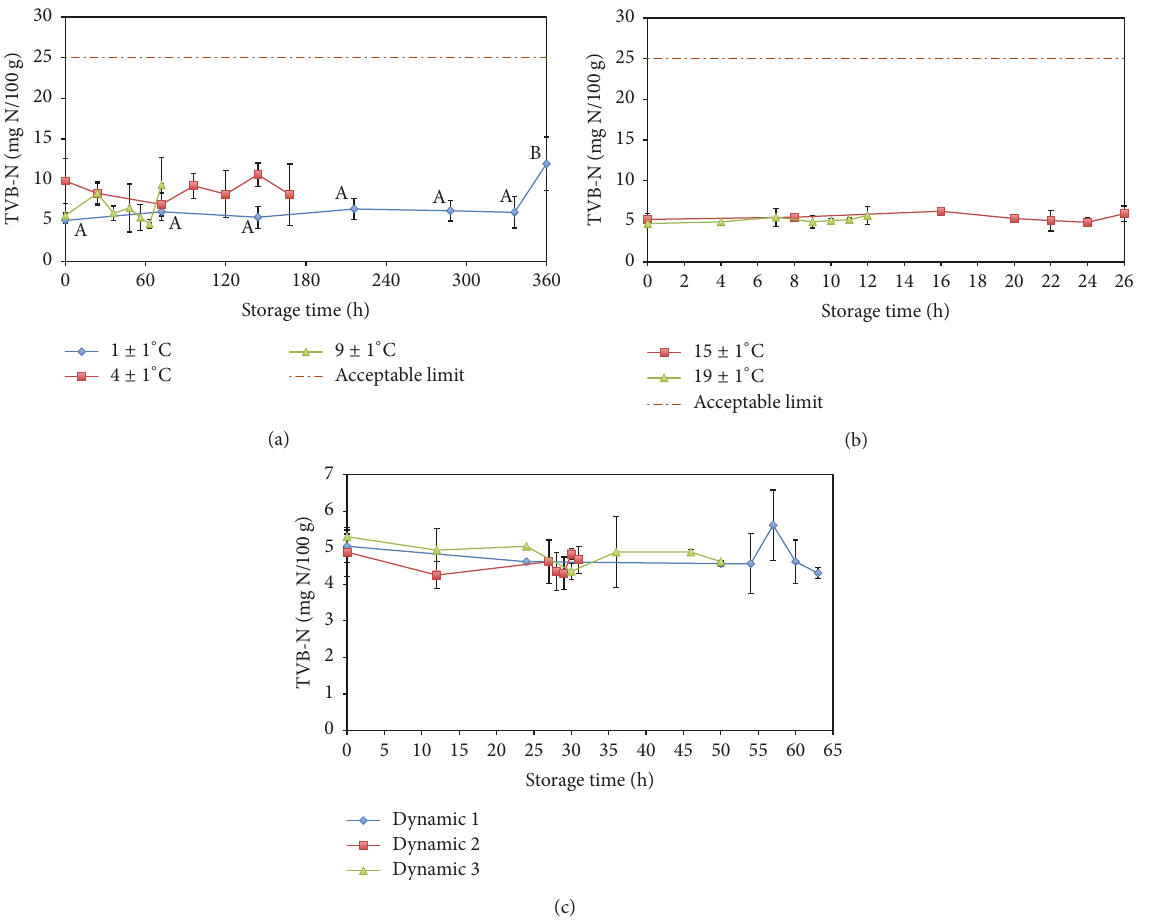
Figure 2: Changes in TVB-N of Pangasius fillets during storage at (a) 1, 4, and 9 ± 1 ∘ C, (b) 15 and 19 ± 1 ∘ C, and (c) dynamic temperature